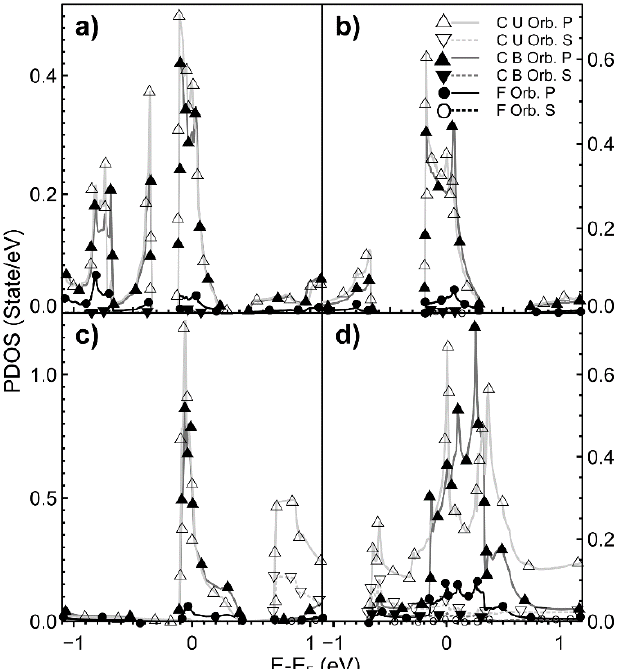
Figure 8. We show the PDOS for different vacancy density values when the dopant is fluorine. In this case, the dopant atom is bound to a carbon atom. ( a ) 2.00%; ( b ) 3.12%; ( c ) 5.55%; ( d ) 12.5%.